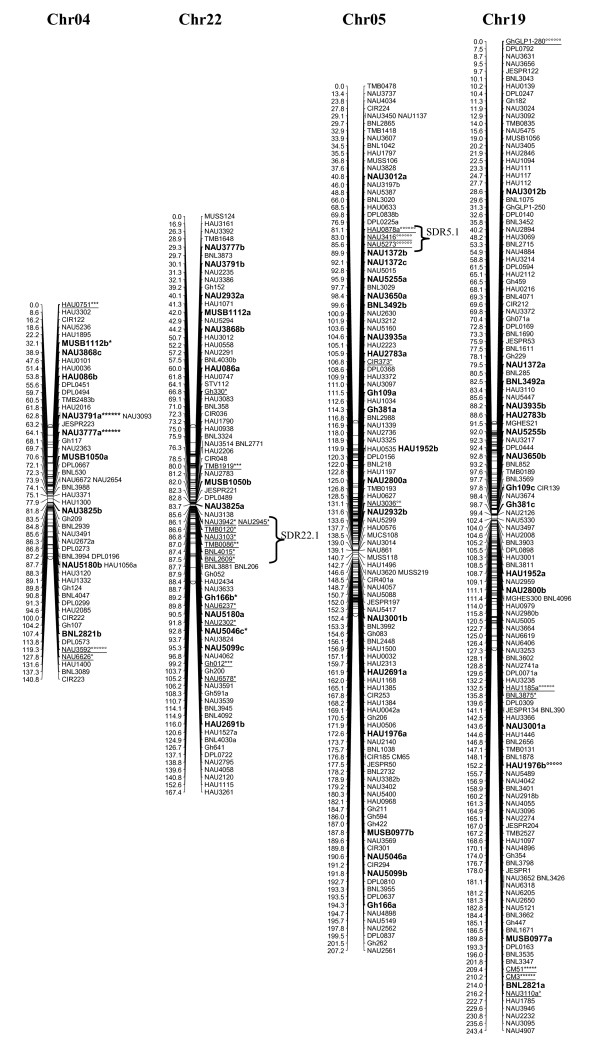
The genetic maps of Chr04/Chr22 and Chr05/Chr19 homoeologous chromosome. All legends are same as described for Figure 1.